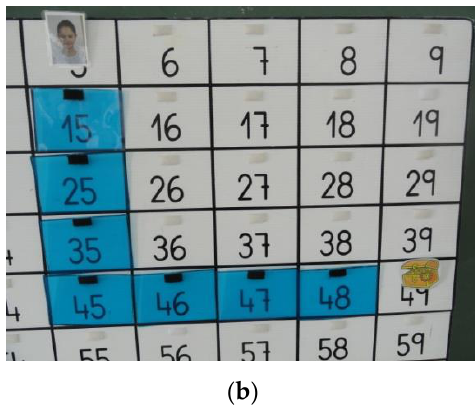
Figure 3. ( a ) Counting in tenths; ( b ) Route from 5 to 49.